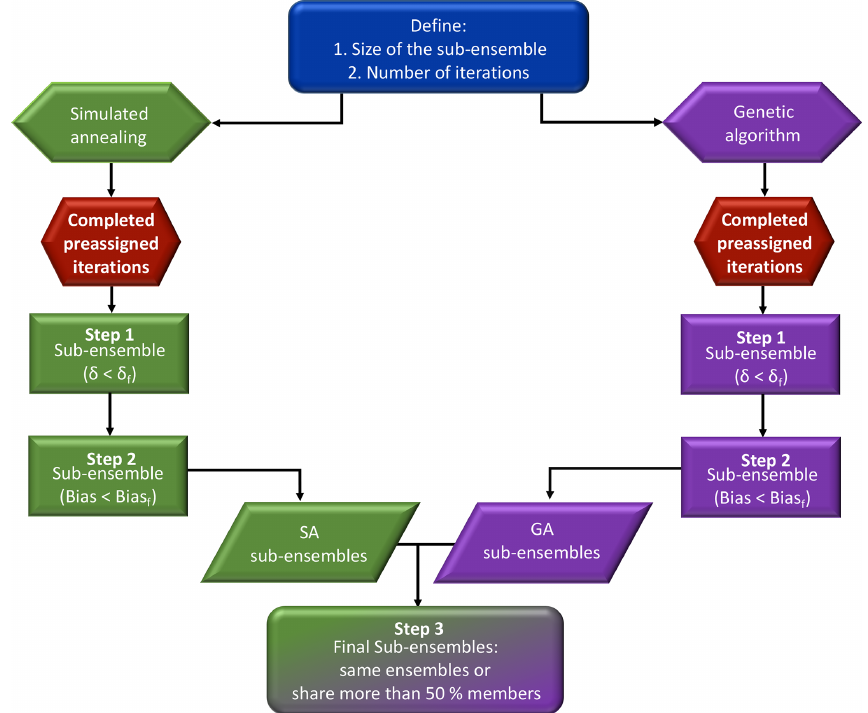
Figure 2. Diagram of the process of selection of reduced-sized ensembles explained in Sect. 2.7. In this diagram, in the sub-ensemble, we show our two main thresholds after running each algorithm; the sub-ensemble score has to be smaller than the full ensemble ( δ < δ f ) and the sub-ensemble bias is smaller than the full-ensemble bias (bias<bias f ).